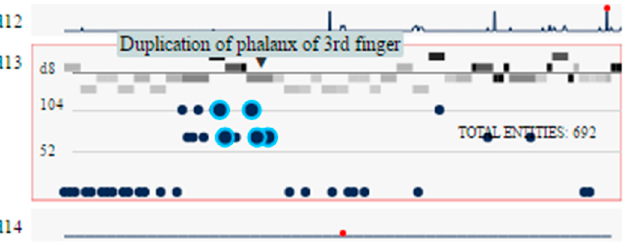
Figure 26. Inspecting the 13th level of the “Skeletal System” ontology section.